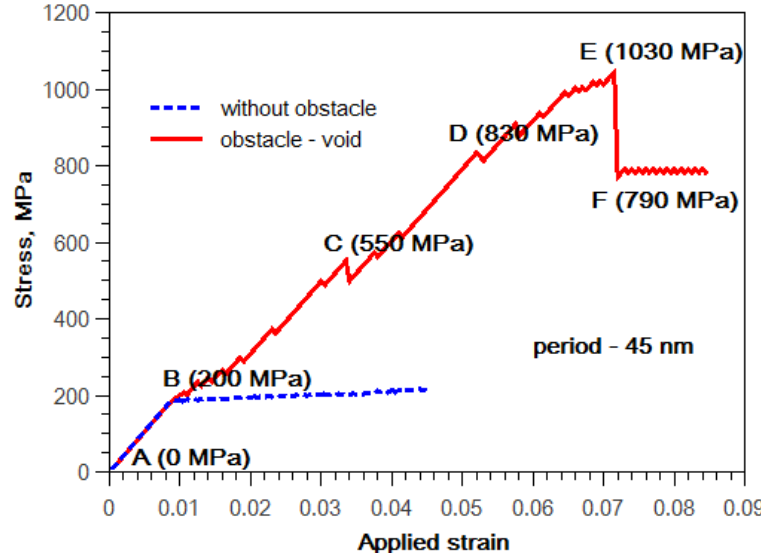
Figure 3. Strain-stress curves for the case of twin boundary migration in the block without the obstacle (blue line) and in the block containing the void (red line).